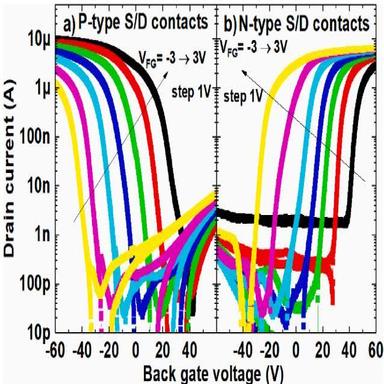
Drain current versus back-gate voltage for various front-gate voltages of a) P + and b) N + source/drain contacts. Both devices have an N + poly-Si gate.